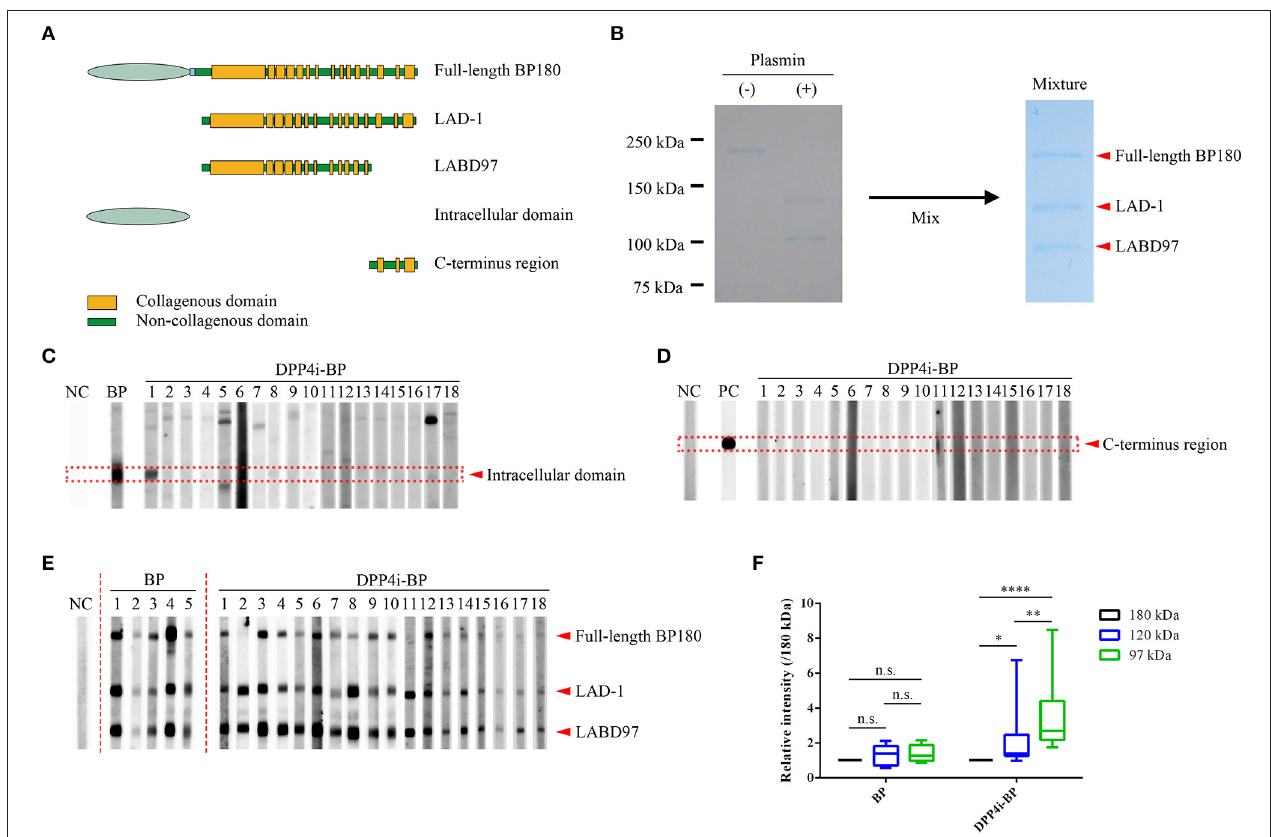
FIGURE 1 | Epitope mapping of DPP4i-BP autoantibodies. (A) Schematic of recombinant proteins. (B) Coomassie Blue staining using a mixture of substrates including the full-length recombinant BP180 and plasmin-digested BP180 proteins. (C–E) Western blots using the intracellular domain of BP180 (C) , C-terminal regions of BP180 (D) , and a mixture of full-length recombinant BP180 and plasmin-digested BP180 proteins (E) . Relative intensities of 180-kDa, 120-kDa, and 97-kDa bands in BP and DPP4i-BP (F) . Data were analyzed using two-way analysis of variance, followed by Tukey’s multiple comparison test. p -values are indicated as *0.01 < p < 0.05, **0.001 < p < 0.01, and **** p < 0.0001. n.s., Not significant; NC, Negative control using healthy individual sera; PC, Positive control using anti-FLAG